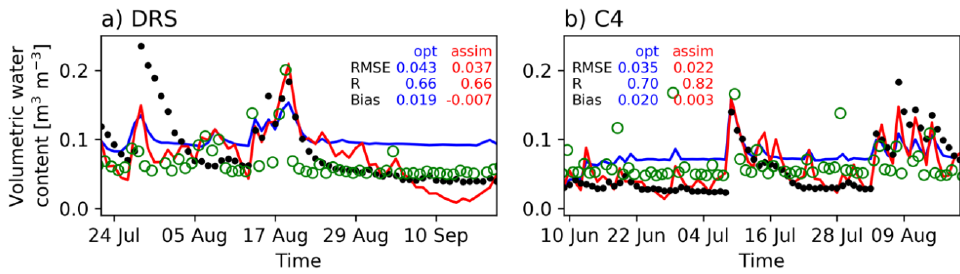
Figure 4. Time series of surface soil moisture (m 3 m -3 ) from the optimized model (blue), assimilated model (red), observation (black dot), and AMSR-E soil moisture (green circle) at ( a ) DRS in 2009 and ( b ) C4 in 2010 in Mongolia. Skill metrics are indicated on each figure as the root-mean-square error (RMSE), correlation (R), and bias.